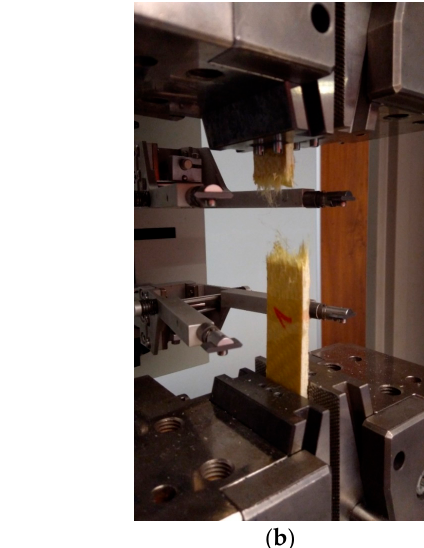
Figure 11. Stress–strain curves of the epoxy composites with various reinforcing materials.